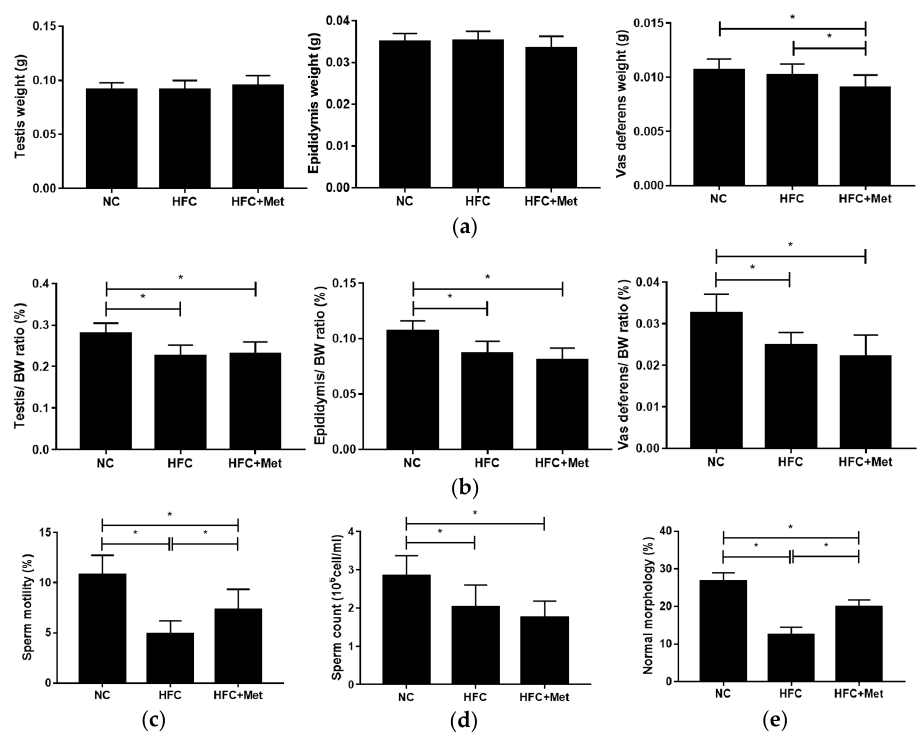
Figure 3. Effects of the high-fat and high-cholesterol diet and metformin supplementation on ( a ) the weights of the testis, epididymis and vas deferens; ( b ) the relative weights of the testis, epididymis and vas deferens; ( c ) sperm motility; ( d ) sperm count; and ( e ) percentage of normal sperm morphology in the male mice: Data are expressed as means ± SD ( n = 9–15 per group). * p < 0.05 as determined by one-way ANOVA followed by LSD post hoc test. NC, normal diet; HFC, high-fat and high-cholesterol diet; HFC + Met, HFC with metformin supplementation.